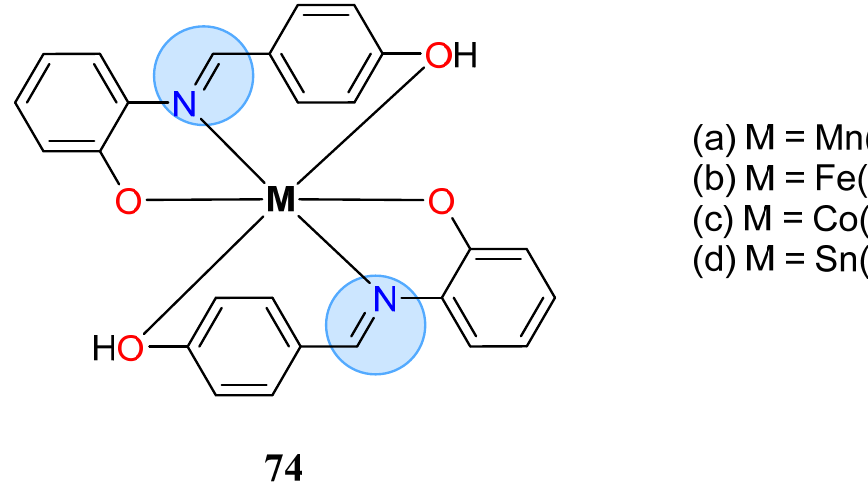
Figure 35. Transition metal complexes of Mn(II), Fe(II), Co(II), and Sn(II) ions with tridentate Schiff base ligand 2-{(4-hydroxybenzylidene) amino}phenol.